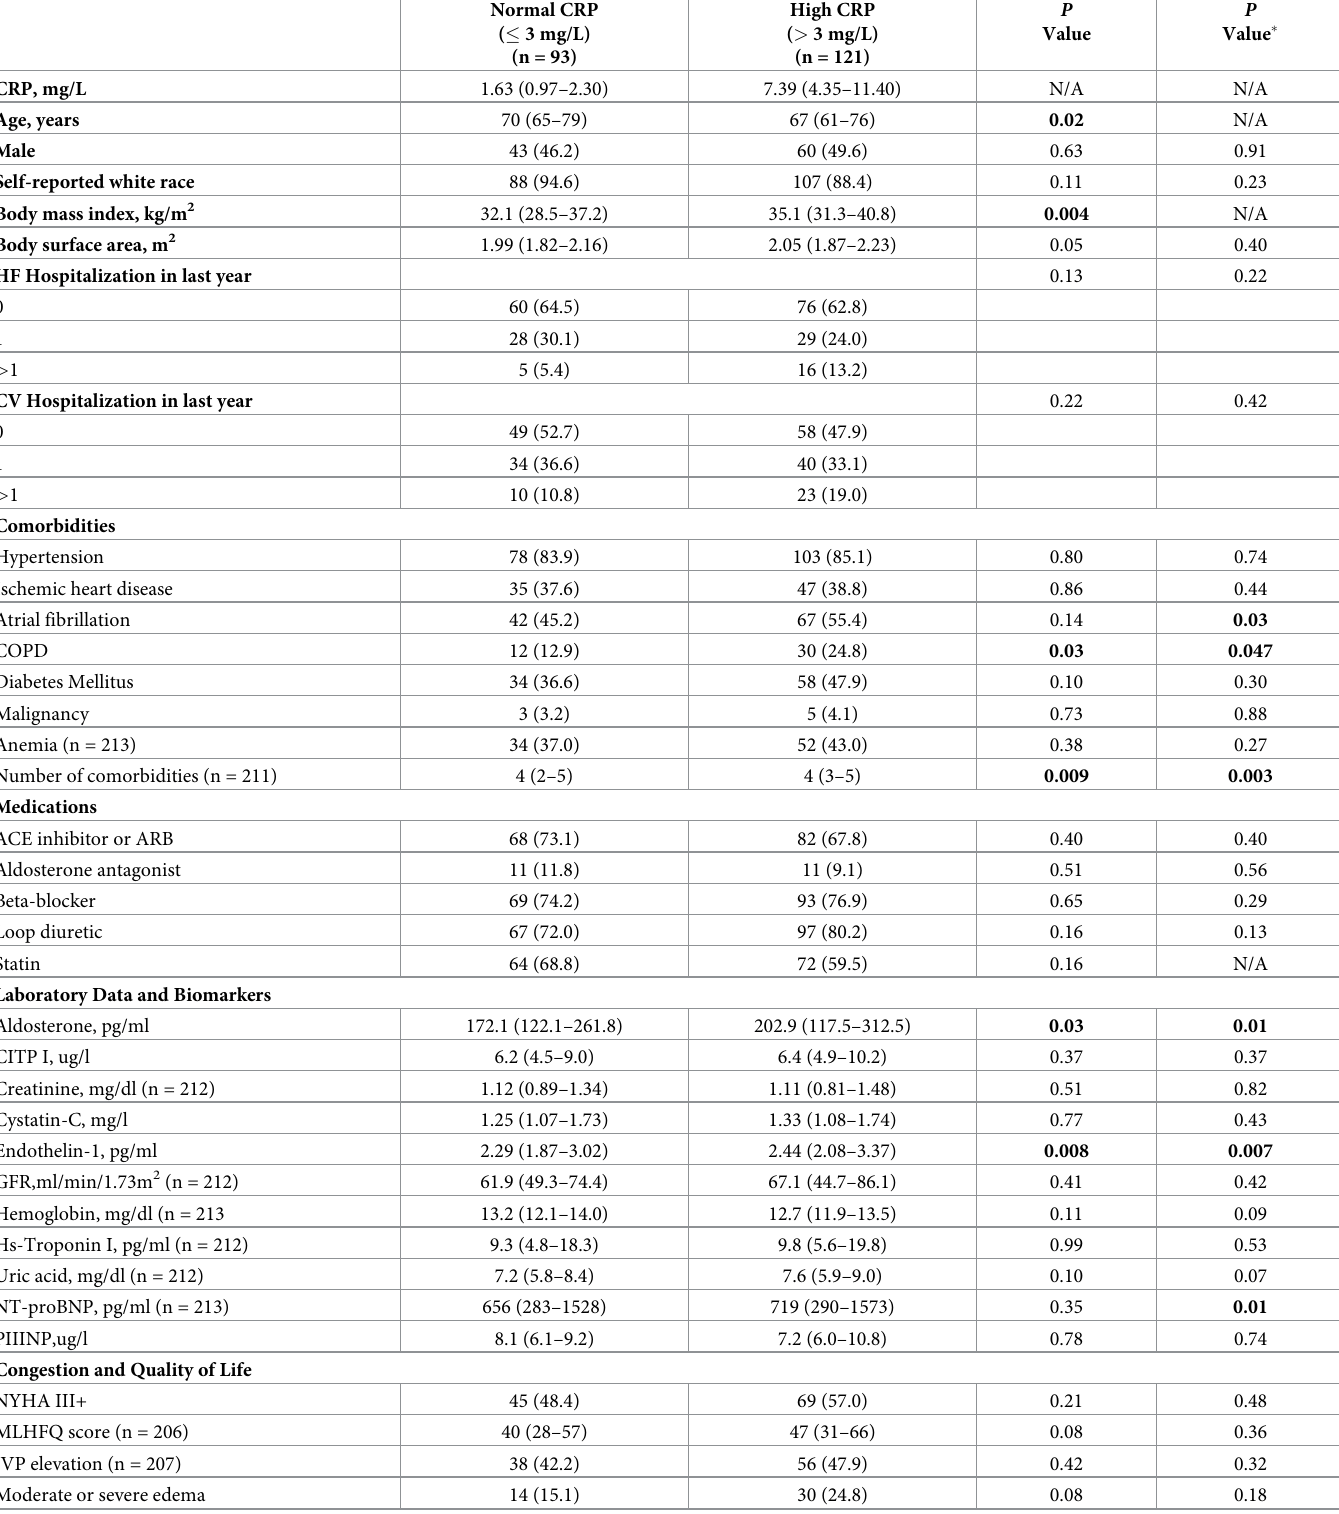
Table 1. Baseline patient characteristics by C-reactive protein